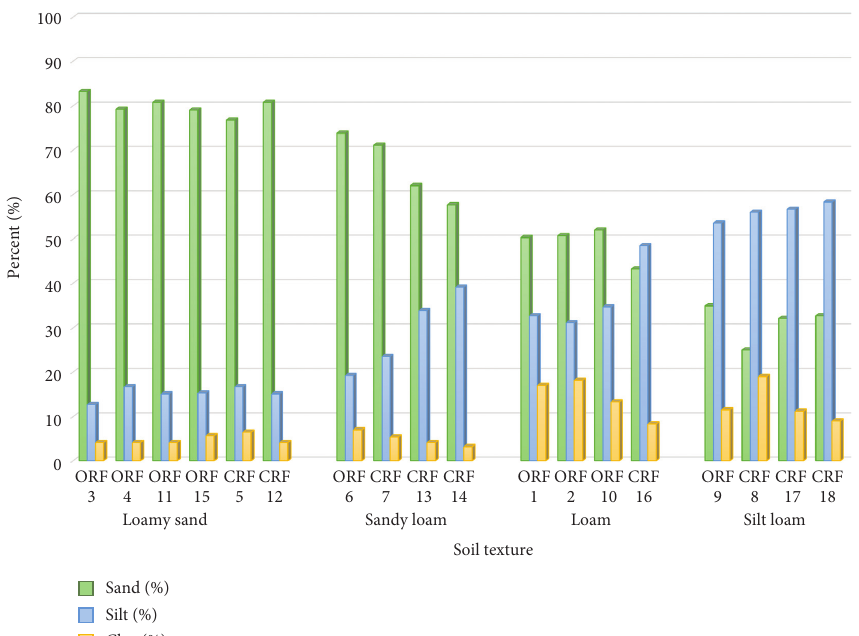
Figure 2: The proportion of sand, silt, and clay particles in the soil of organic and conventional rice farming (ORF and CRF, respectively) sites for each soil textural class.